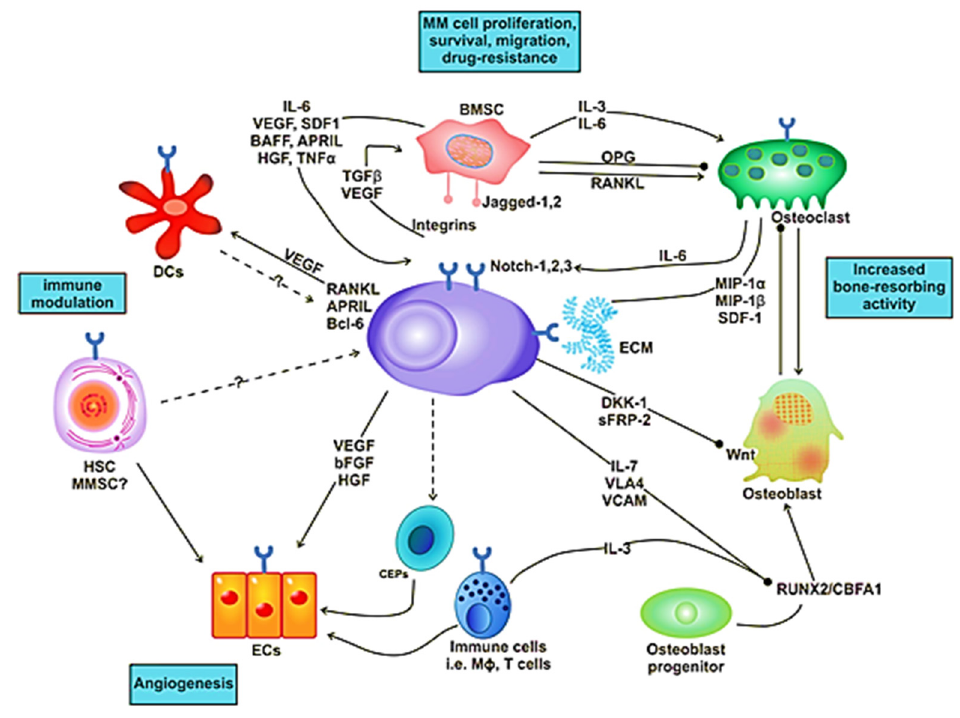
Figure 2. Interaction of MM cell with different compartments of the bone marrow (BM) microenvironment.